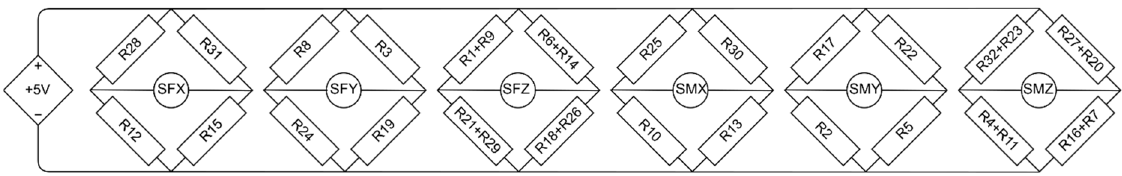
Figure 10. Six Wheatstone bridges circuit.